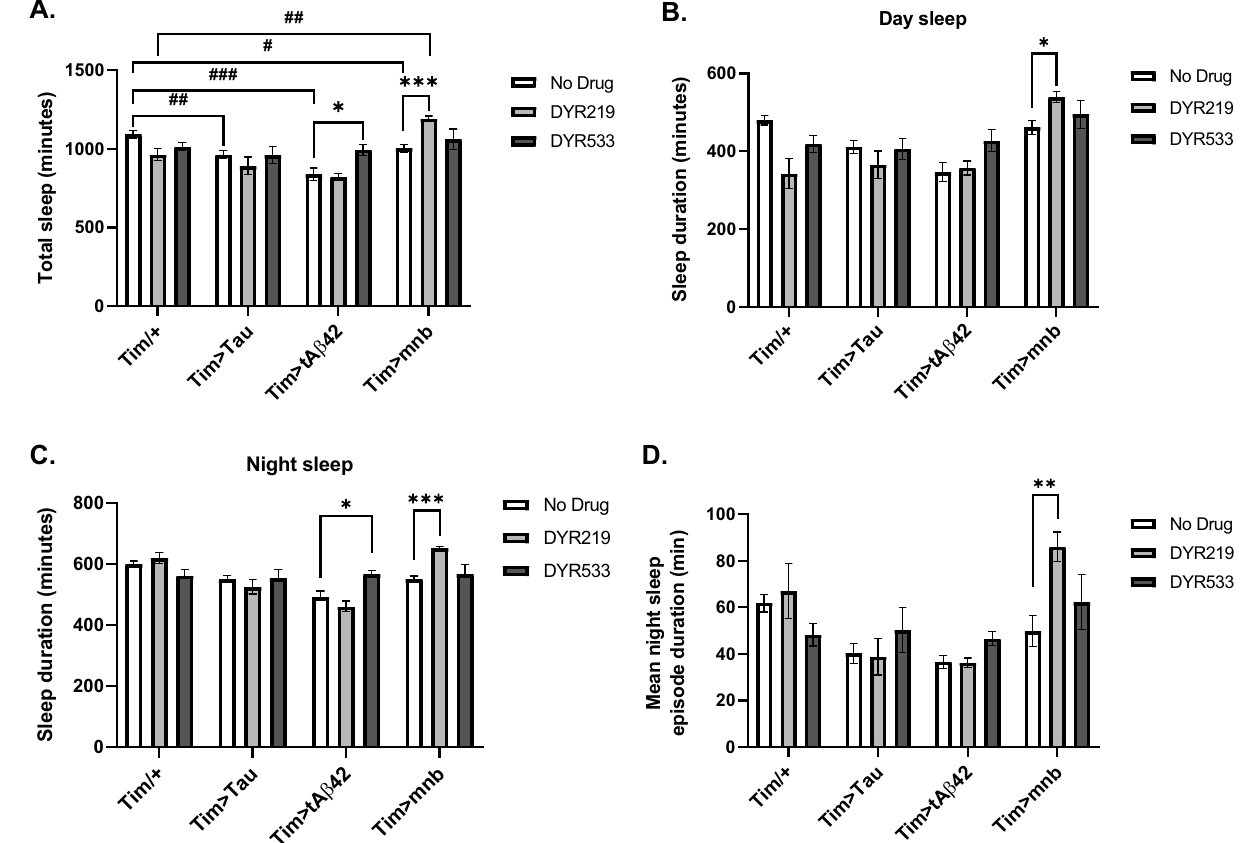
Figure 5. Overexpression of human Tau, tAβ42 and mnb throughout the clock caused sleep loss improved by DYRK1A inhibitors. ( A ) Clock-wide ( timeless (tim)-Gal4 ) overexpression of human Tau, tAβ42 or mnb reduced total sleep compared to control ( tim/ +) off drug (white bars). DYR219 increased total sleep of mnb overexpressing flies and DYR533 increased total sleep of flies overexpressing tAβ42 in their clock. The total amount of sleep can be split into sleep occurring in the day ( B ) and night ( C ), overexpression of the disease associated genes reduced sleep both during the day and night. This revealed that DYR219 was effective at increasing sleep loss during the day and night of mnb overexpressing flies, while DYR533 treated the loss of nocturnal sleep of tAβ42. ( D ) Mean nocturnal sleep episode duration was measured and found to be increased by DYR219 treatment of flies with clock-wide overexpression of mnb. 2-way ANOVA with Bonferroni’s multiple comparisons test ( * P < 0.05, ** P < 0.01 and *** P <